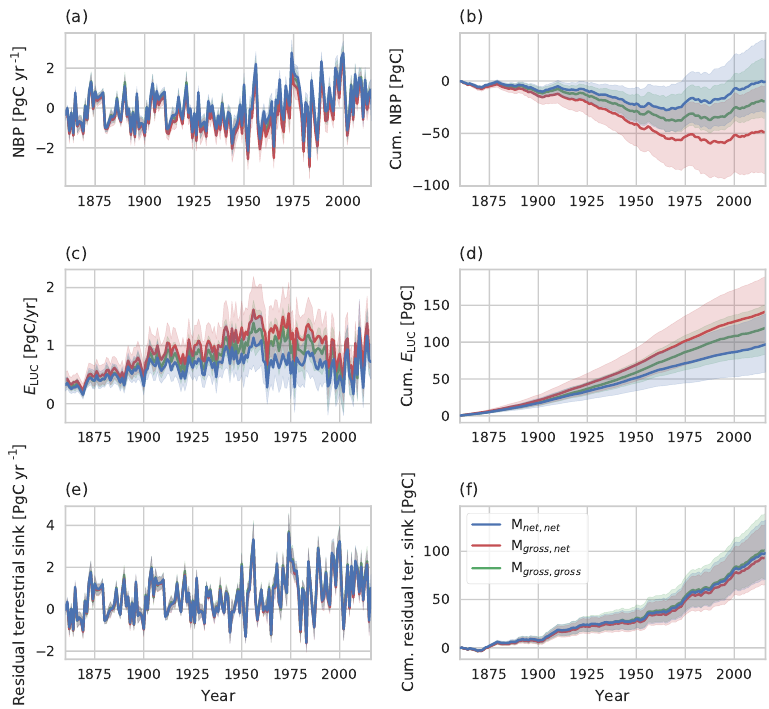
Figure 3. Skill weighted median net biome production (NBP) (a) , emissions due to LULCC E LUC (c) , and the residual terrestrial sink flux (e) and their respective cumulative fluxes (b, d, f) for the constrained ensemble with net land use M net , net (blue), additional gross land- use processes M gross , net (red) and gross land use with skill scores recalculated M gross , gross (green). The shading corresponds to the 90% confidence